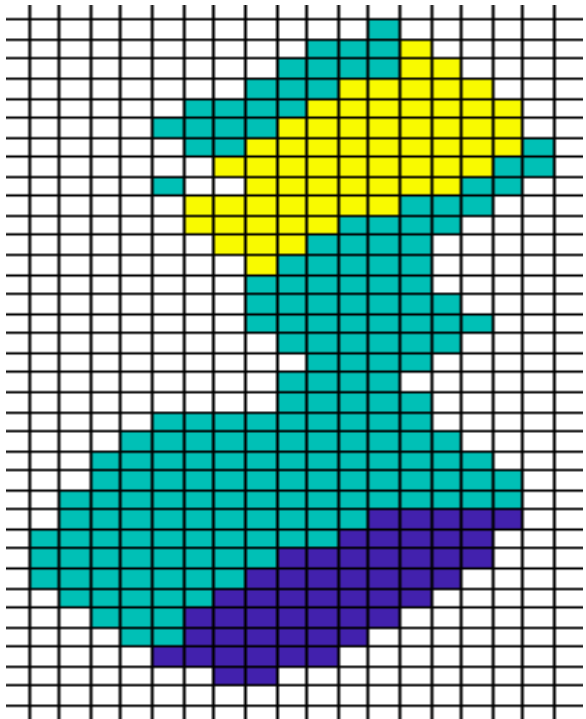
Figure 8. Clustering of Bridgeton landfill based on means and standard deviations of all observations.